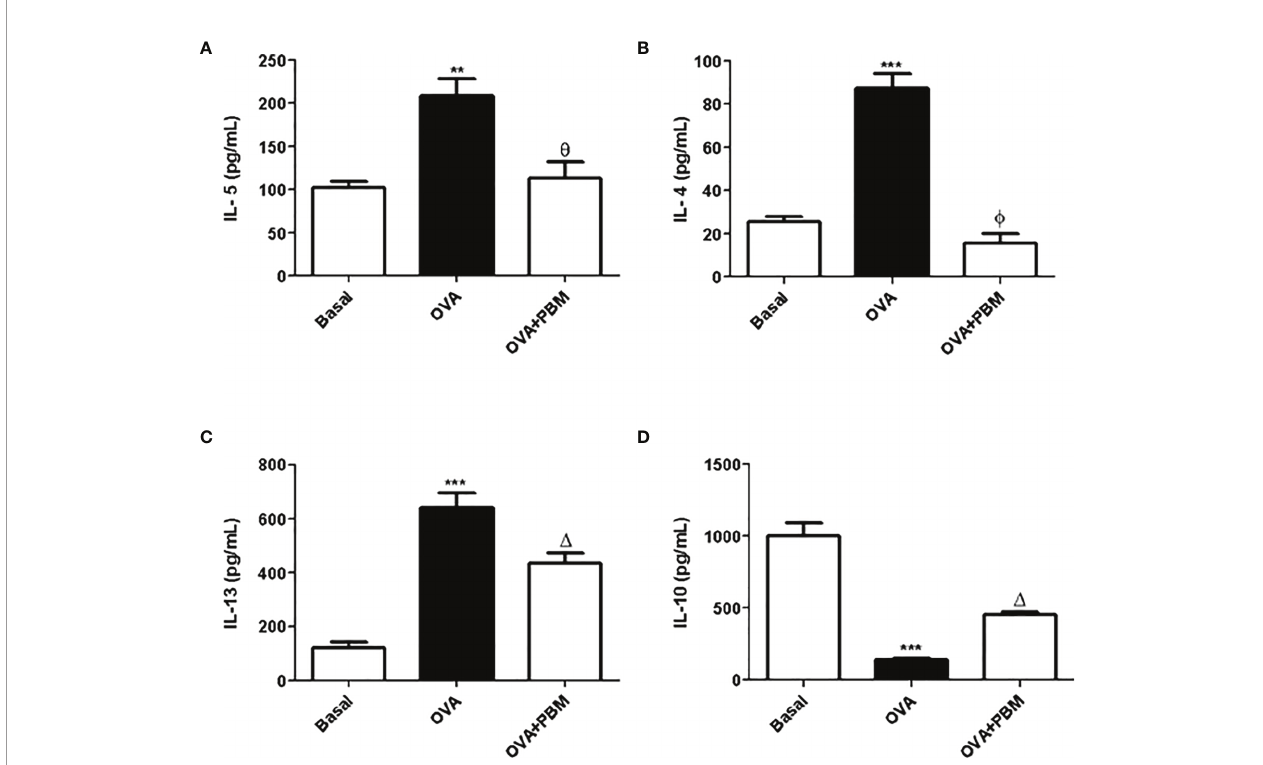
FIGURE 2 | Effect of photobiomodulation on BAL cytokine. In (A) IL-5, (B) IL-4, (C) IL13, and (D) IL-10 in the BAL supernatant. Basal group, n = 5; OVA group, n = 7; PBM group, n = 5; OVA+ PBM, n = 8. Two independent sets of experiments were carried out. Data represent mean ± standard error (SEM). ** p < 0.01 and *** p < 0.001 in relation to the Basal group; D p < 0.05; q p < 0.01; f p < 0.001 in relation to the OVA